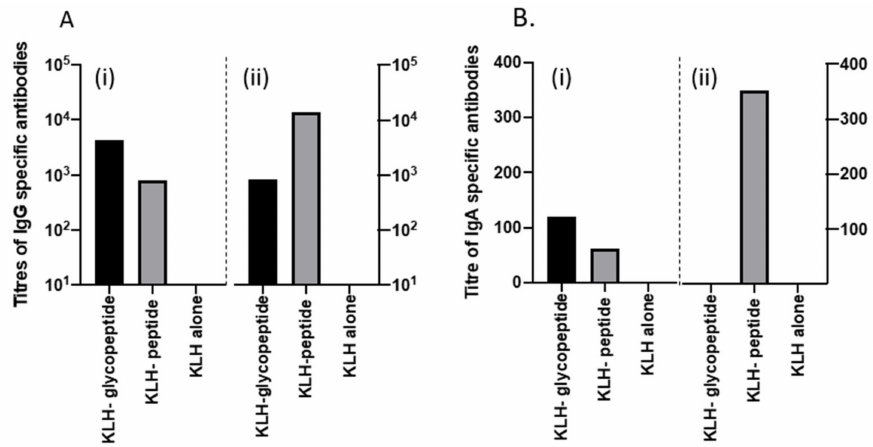
Figure 7. Antibody response to intranasal vaccination of the peptides and CT in the serum of mice following immunizations on days 1, 14, and 21. ( A ) shows the IgG specific response to both the KLH glycopeptide conjugate (balck), KLH peptide (grey), and KLH alone (white), respectively. Figure 7A (i) shows the calculated titers when the glycopeptide was used as the coating antigen and 7A (ii) when the peptide alone was used. ( B ) shows the IgA specific response to both the KLH glycopeptide conjugate (black), KLH peptide (grey), and KLH alone (white), respectively. Figure 7B (i) shows the calculated titers when the glycopeptide was used as the coating antigen and 7B (ii) when the peptide alone was